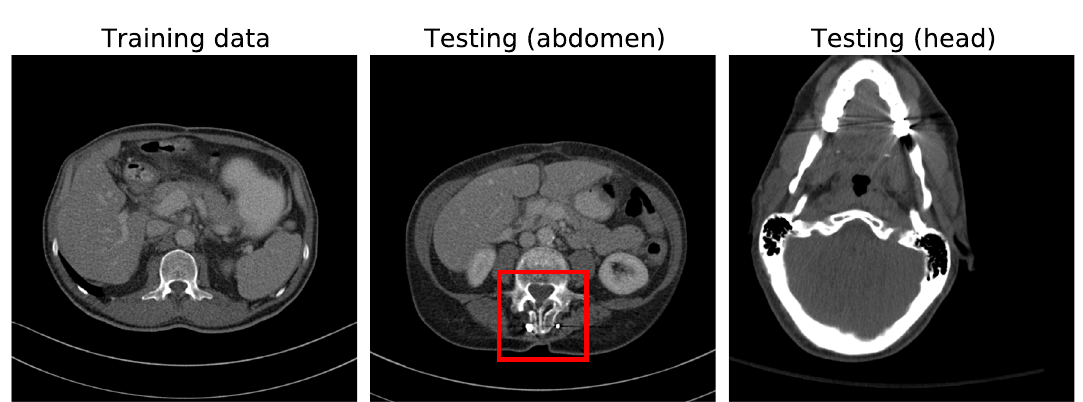
Figure 3. Exemplary slices from the training (left, abdomen without metal) and two testing (middle, right) data sets. The abdomen test patients contain regions with metal implants like the one highlighted in red. The reconstruction window is [− 150, 500 ] HU